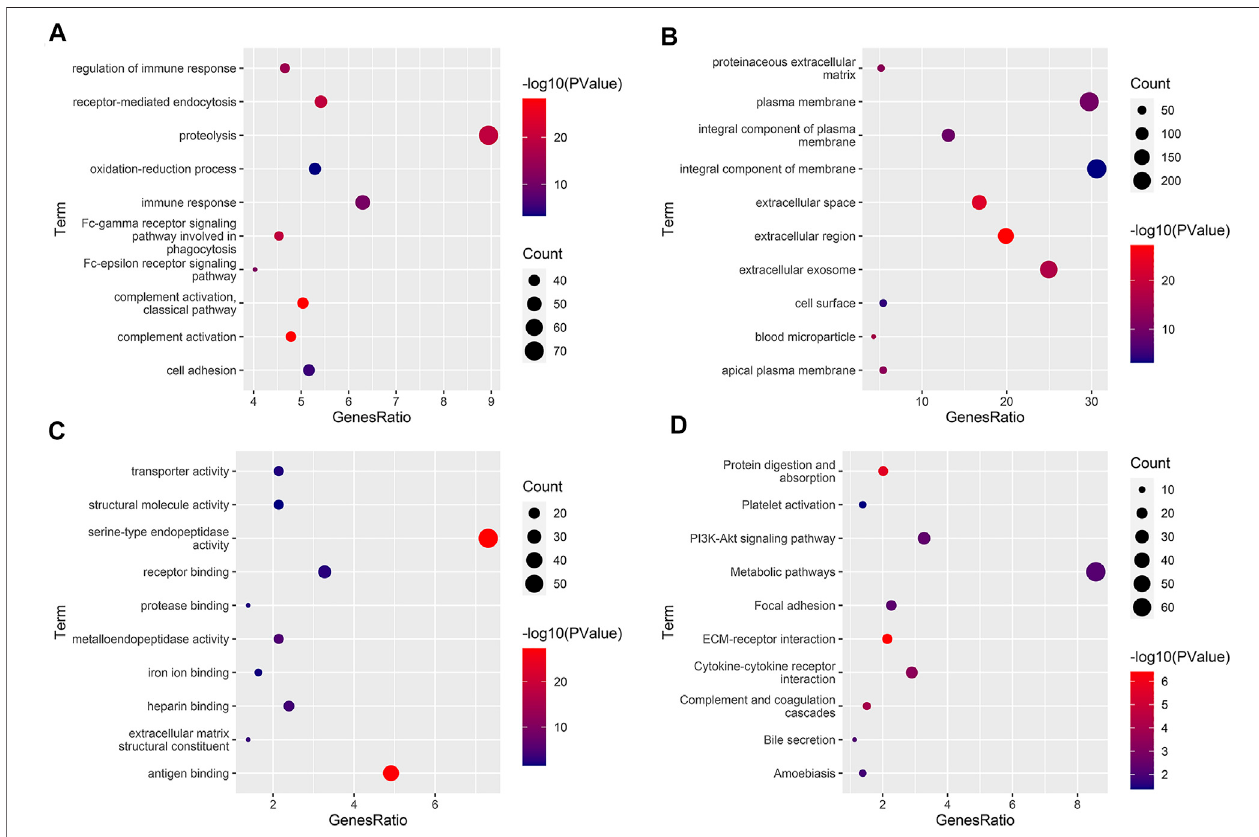
FIGURE 5 | Functional enrichment analyses. (A – C) The signi fi cantly enriched GO term (top 10). BP, biological process (B) . CC, cellular component (B) . MF, molecular function (C) . (D) The signi fi cantly enriched KEGG pathway (top 10). GO, Gene Ontology; KEGG, Kyoto Encyclopedia of Genes and Genomes.